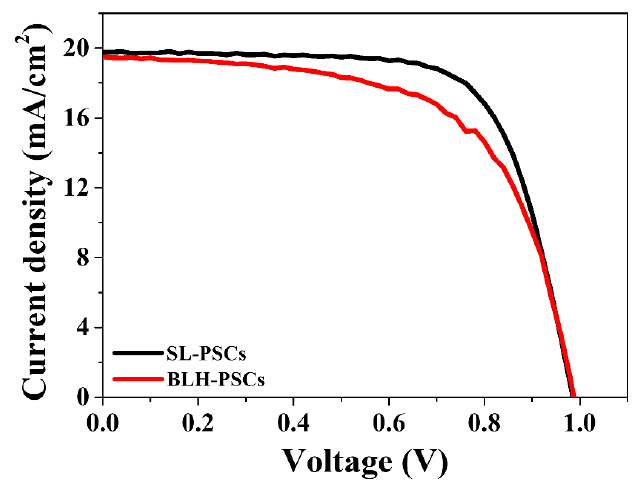
Figure 1. Reverse scan current density–voltage (J-V) curves of SL-PSC and BLH-PSC.